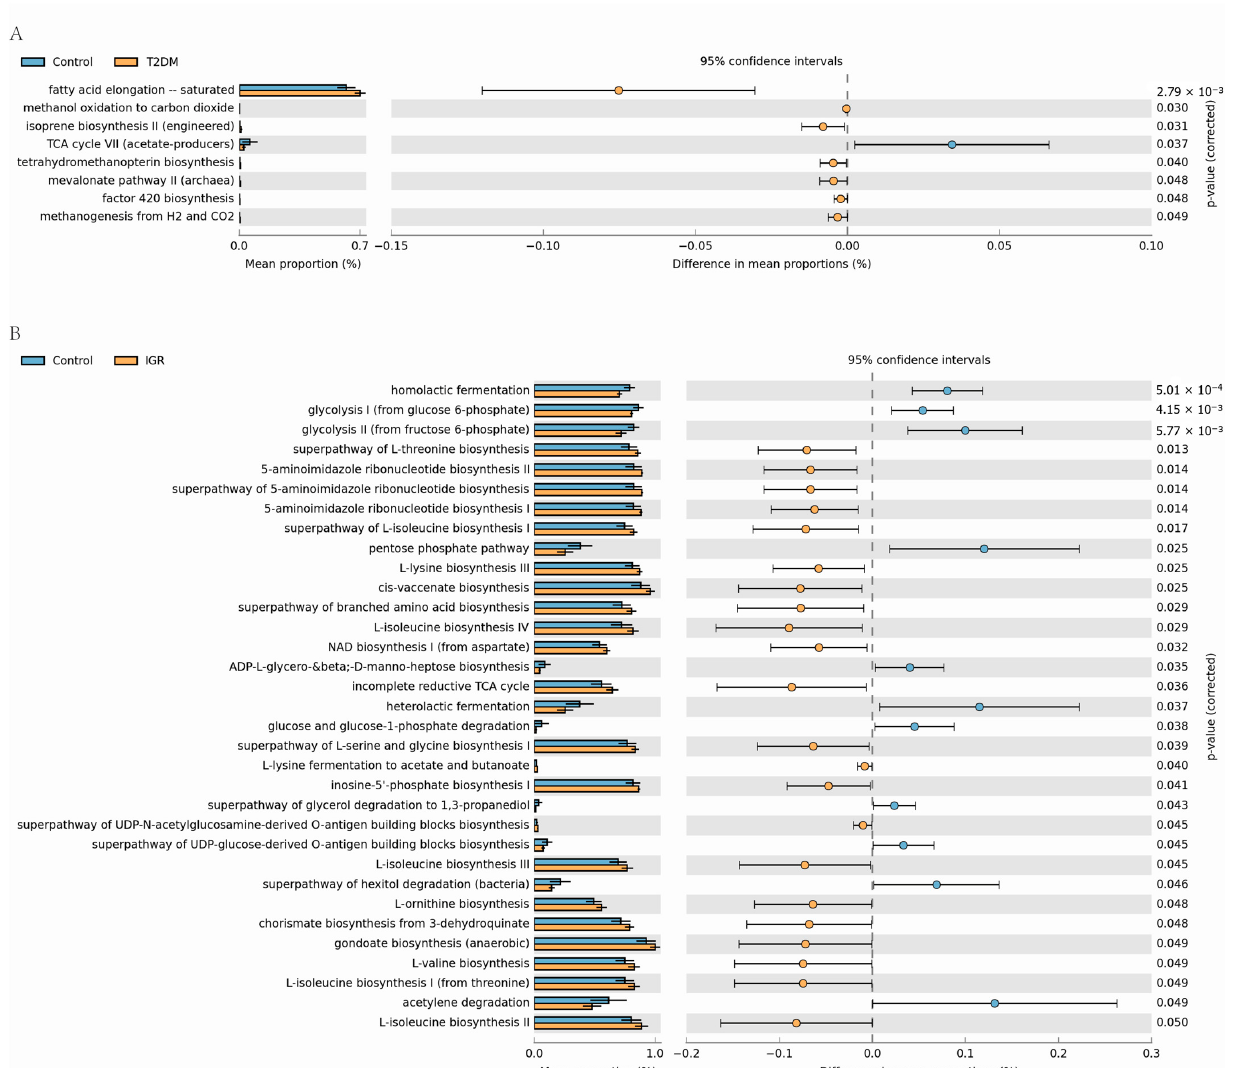
Figure 2. Functional differences of gut microbes between T2DM and Control groups ( A ), IGR and Control groups ( B ) ( p < 0.05). Orange box: T2DM or IGR samples, blue box: